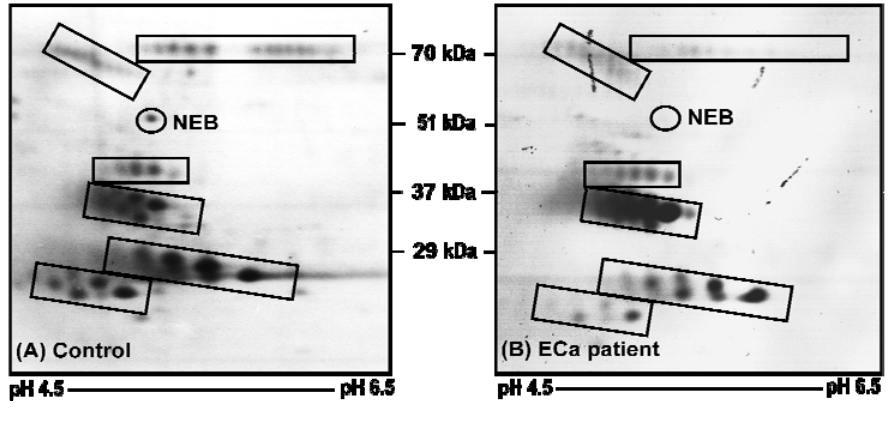
Figure 2. Typical 2-DE urinary O -glycoprotein profiles. Panels ( A ) and ( B ) refer to 2-DE urinary O -glycoprotein profiles of a control subject and a patient with stage IB ECa, respectively. Spot clusters that are marked in boxes are proteins, which were consistently detected by CGB lectin. NEB refers to nebulin. The acidic side of the membranes is to the left and the relative molecular mass declines from the top.